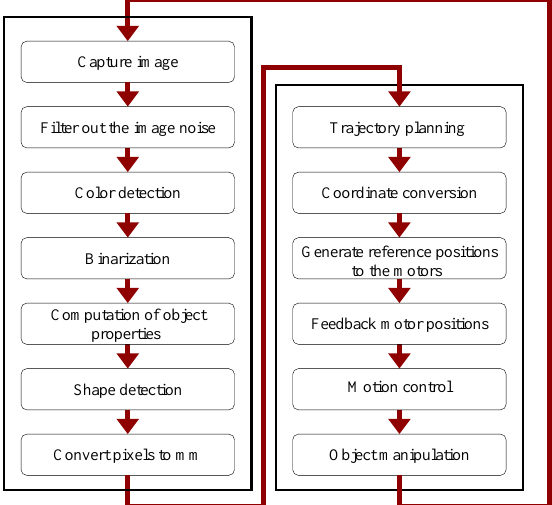
Figure 14. Logic sequence to control the manipulator using artificial